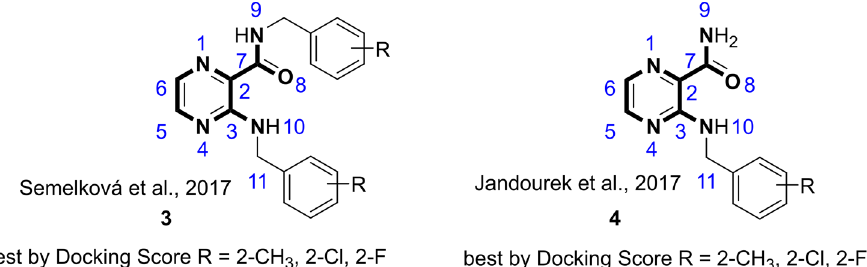
Figure 2. Selected hits from the initial in silico screening of our in-house database [17,18]. The atom numbering of the compound scaffold is shown in the structure.